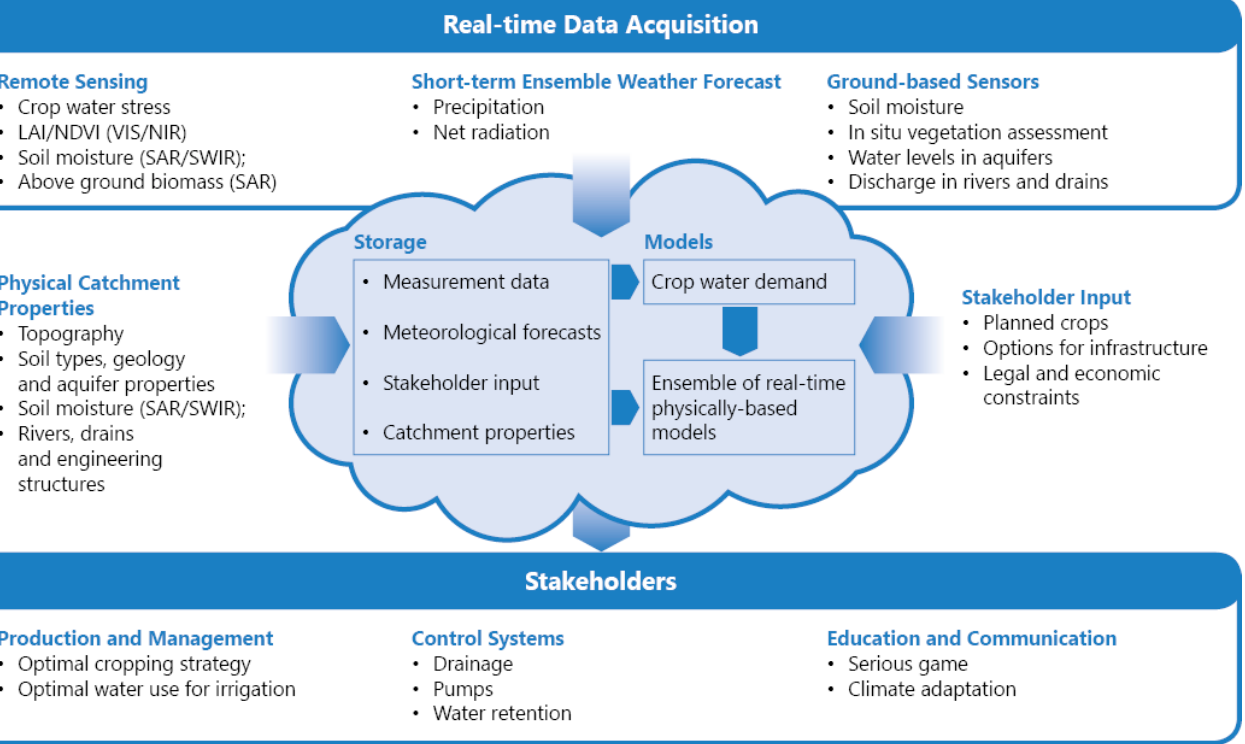
Figure 2. Data gathering and analysis approaches within the WATERAGRI Modeling Framework (A1) to support WATERAGRI solutions benefitting stakeholders in agriculture. (A1) to support WATERAGRI solutions benefitting stakeholders in